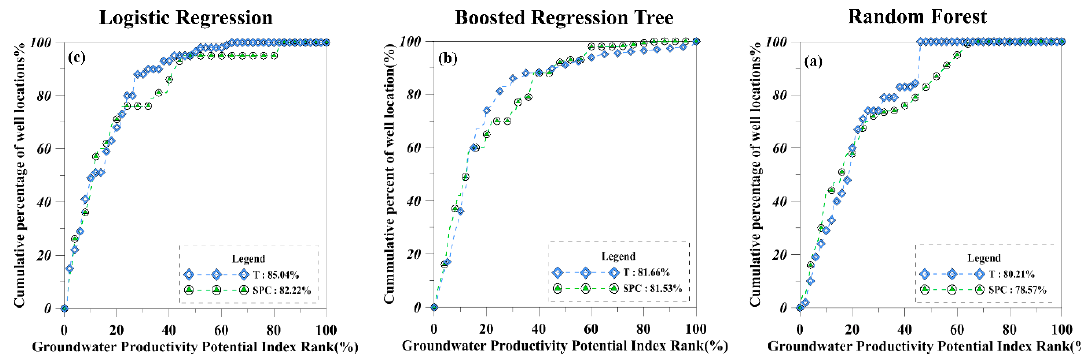
Figure 5. ROC curves for the GPP maps with T / SPC values produced by ( a ) LR model, ( b ) BRT model and ( c ) RF model.